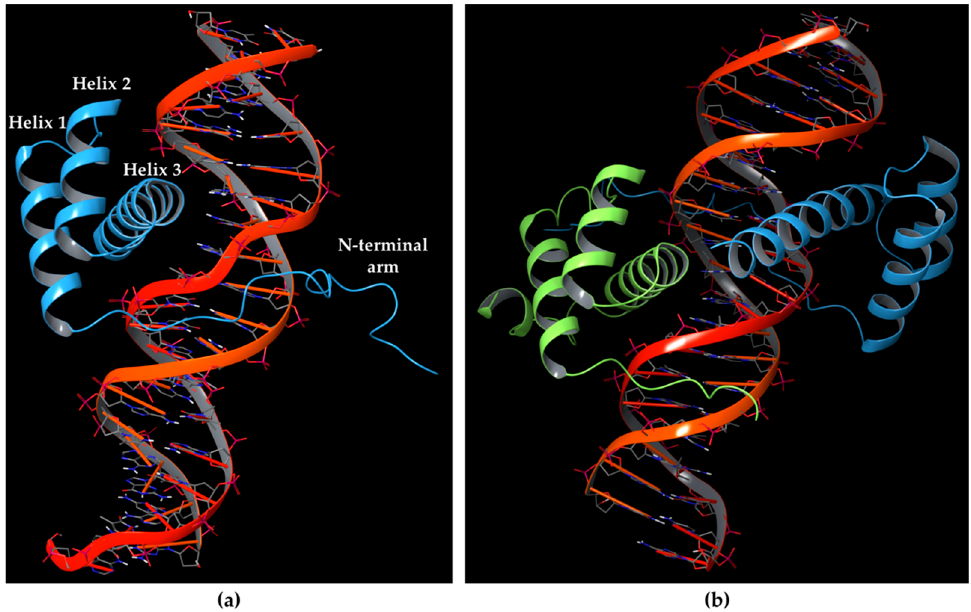
Figure 1. ( a ) Homeodomain of HOXA9 protein (light blue chain) showing a triple-helix structure where helix 3 insert the DNA major groove, while the N-terminal arm establishes contacts with DNA minor groove (PDB ID: 1PUF [27]); ( b ) HOXA9-PBX1 cooperative binding in presence of DNA retrieved from PDB 1PUF [27], where the red double-helix structure is DNA bound to the Homeobox protein HOXA9 (light blue chain) and Pre-B-cell leukaemia transcription factor-1 PBX1 (green